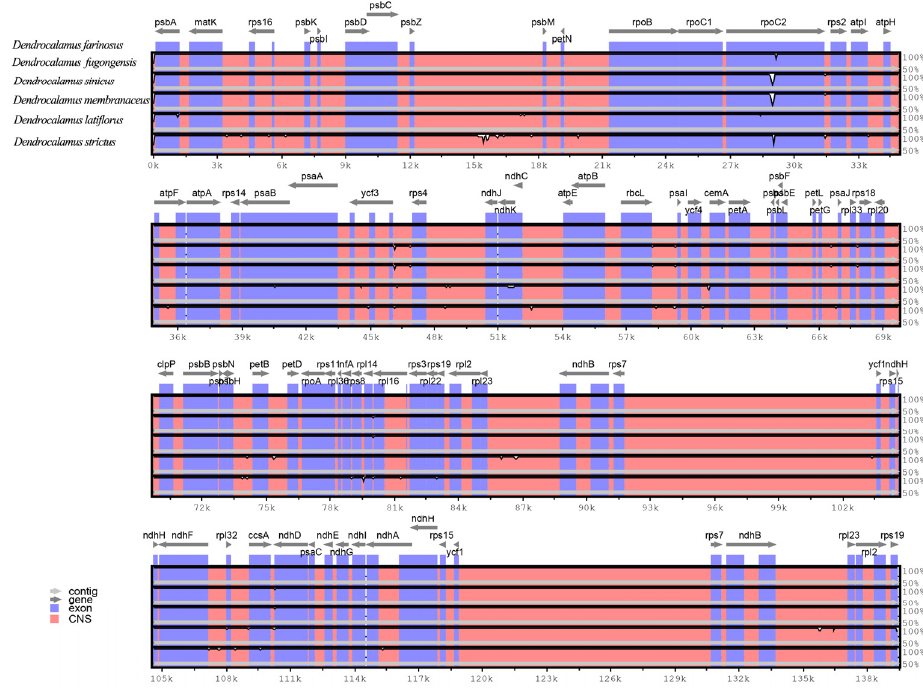
Figure 3. Sequence alignment of the six cp genomes of Dendrocalamus by mVISTA, using D. farinosus as the reference. The six genomes of Dendrocalamus are D. farinosus , D. fugongensis , D. sinicus , D. membranaceus , D. latiflorus and D. strictus . The horizontal axis indicates the coordinates within the cp genome. Genome regions are color-coded as follows; genes are represented in blue; conserved non-coding sequences are represented in dark pink; forward and backward arrows represent the direction of the gene.